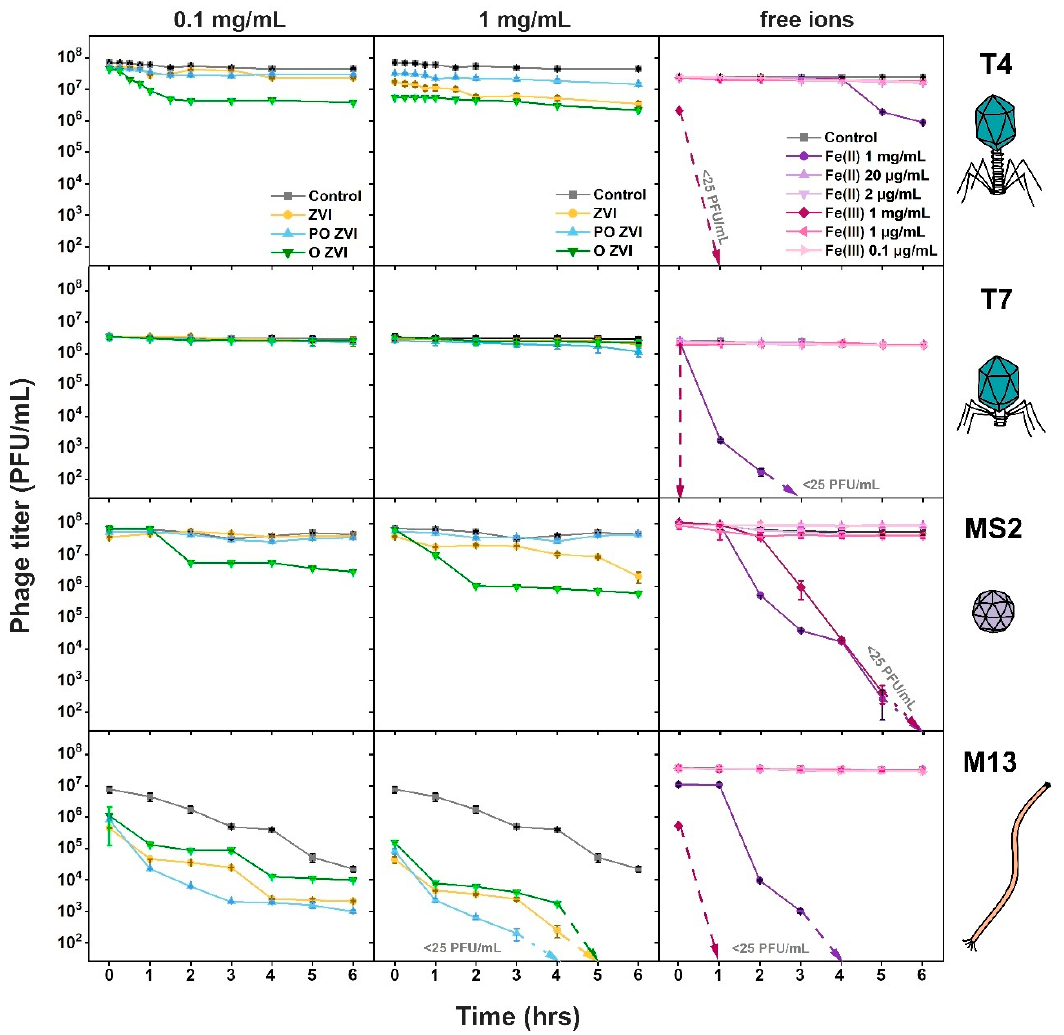
Figure 2. PFU/mL calculation of bacteriophages in TM buffer, ZVI (0.1 and 1 mg/mL), partially oxi- dized and M13 in the presence of Fe (II) (1 mg/mL 20 μ g/mL and 2 μ g/mL) and Fe (III) ions (1 mg/mL, 1 μ g/mL and 0.1 μ g/mL). Cartoons depicting phages are reprinted from [55] with permis- sion from Elsevier.